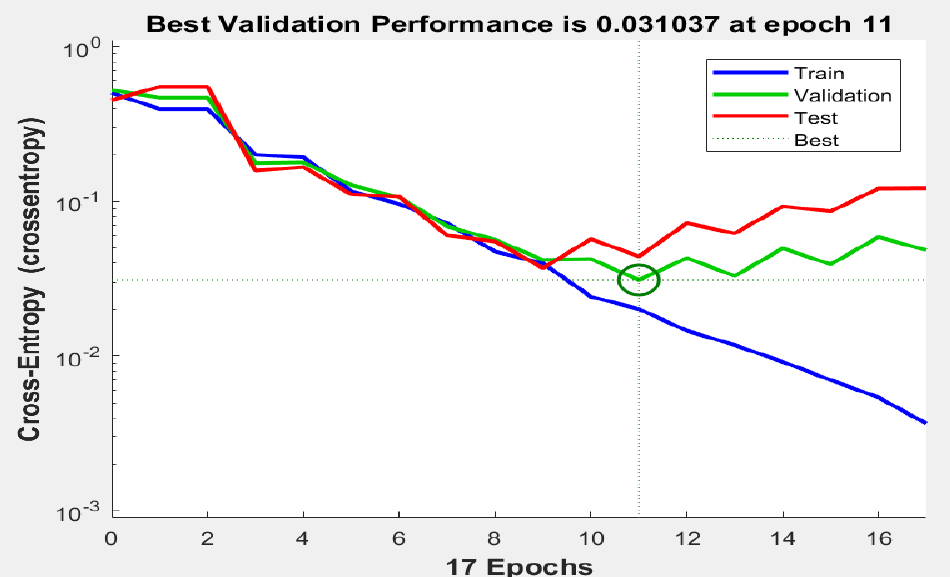
Figure 9. The achieved cross-entropy results.